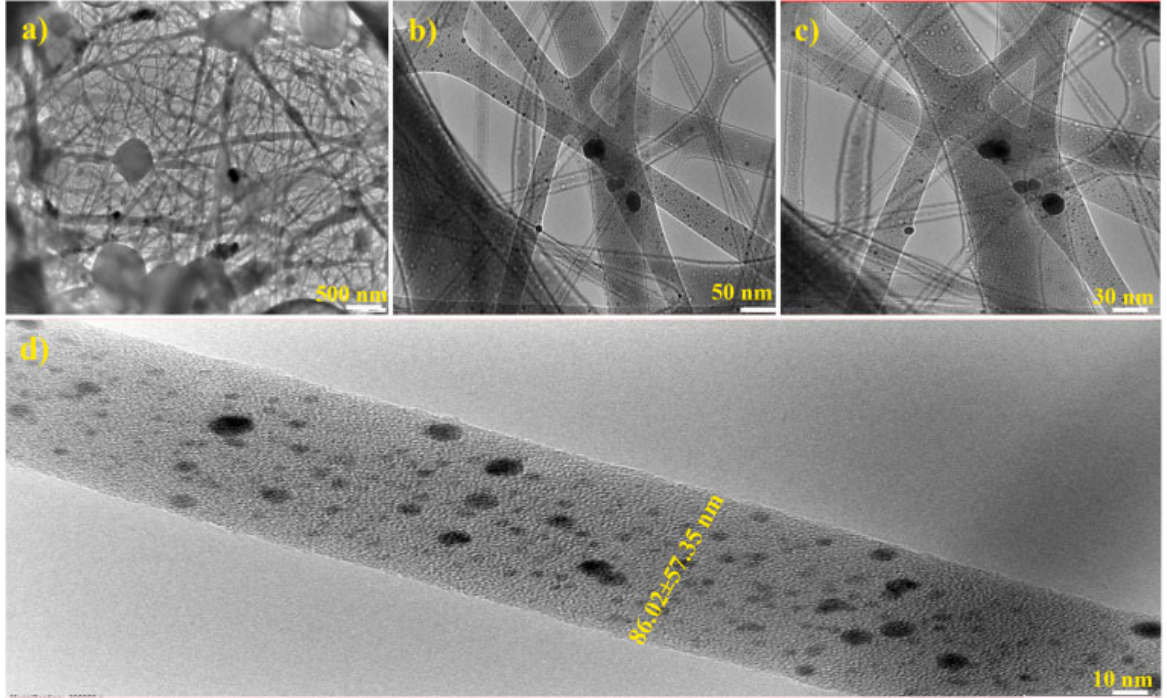
Figure 2. TEM images of fabricated CA/SF/Au ‐ Ag composite NFs at different magnifications. ( a ) 500 nm; ( b ) 50 nm; ( c ) 30 nm; ( d ) 10 nm. Reprinted/adapted with permission from Ref. [53]. 2021, Elsevier.